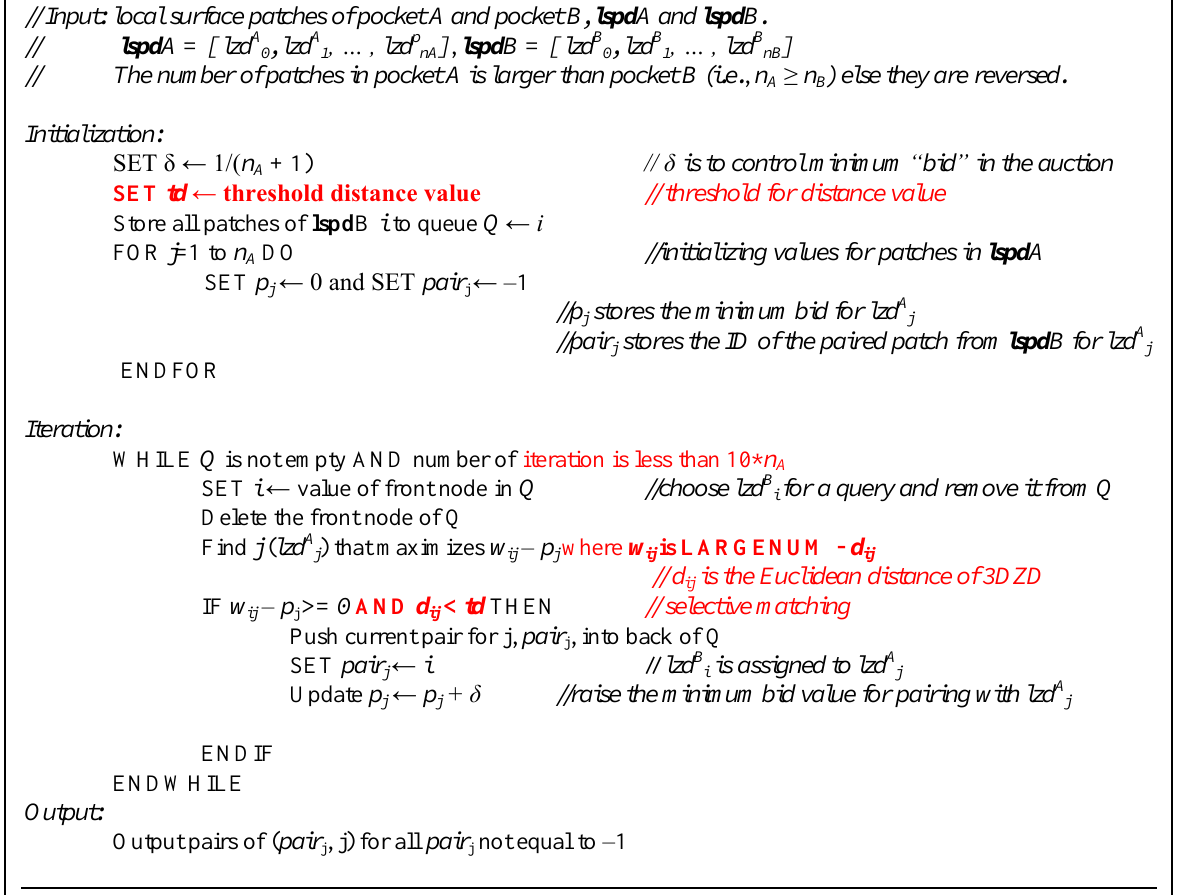
Figure 3. Modified auction algorithm for bipartite matching. Modification to the original algorithm is indicated in